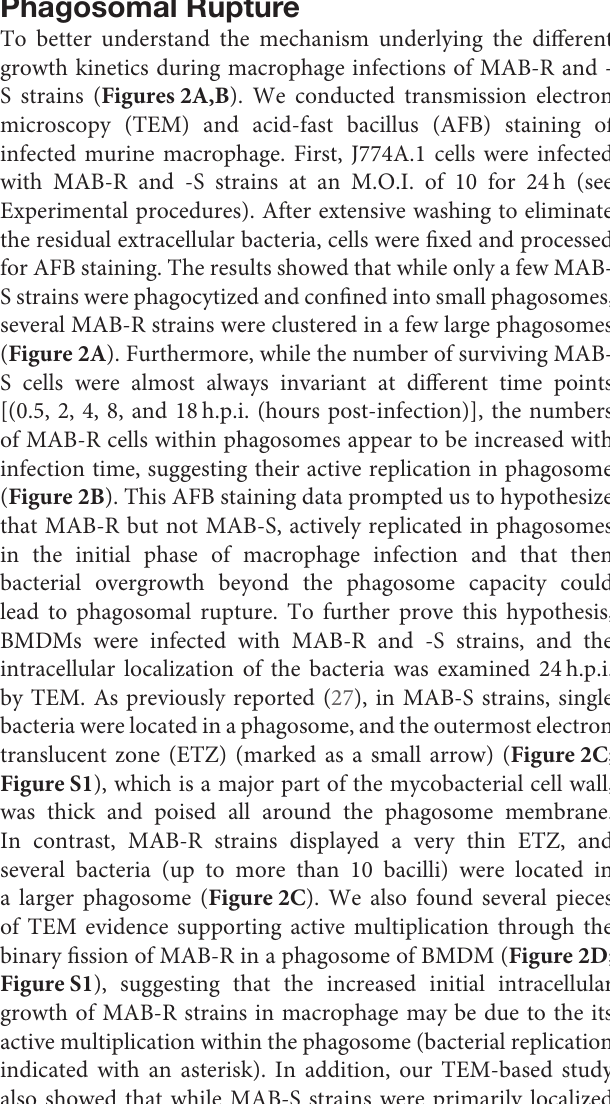
FIGURE 1 | [S-Abs_R ( M. abscessus type strain ATCC 19977 rough strain) and S-Mas_II-R (Asan 50594)] and MAB-S strains [S-Abs_S ( M. abscessus type strain ATCC 19977 smooth strain) and S-Mas_I-S (Asan 51843)] at 37 ◦ C at different time points (2, 6, and 24h) after infection of BMDM at 10M.O.I. (D–F) Comparison of the mean value of proinflammatory cytokine production (TNF- α , IL-6, and IL-10) between various MAB-R and -S strains (10M.O.I, at 24h.p.i) from infected J774A.1 cells (D) , BMDMs (E) , and BMDCs (F) . The results are representative of two independent experiments and represent means ± SD . P -values were determined by one-way ANOVA with Tukey’s multiple comparison test (B,D–F) and paired Student’s t -test (C) using GraphPad prism program: ns, non-significant; * P < 0.05; ** P < 0.01, and *** P <